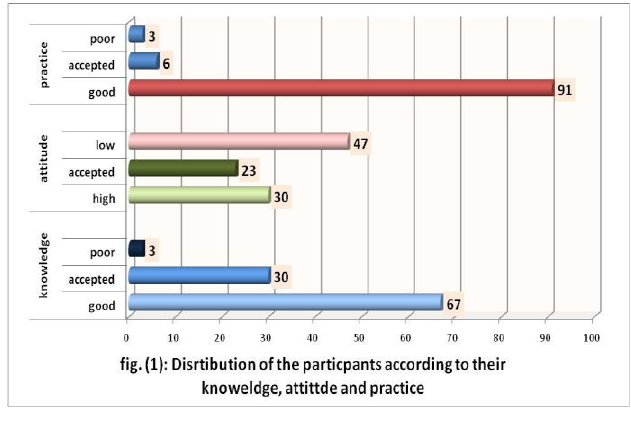
Table 2 : Relationship of